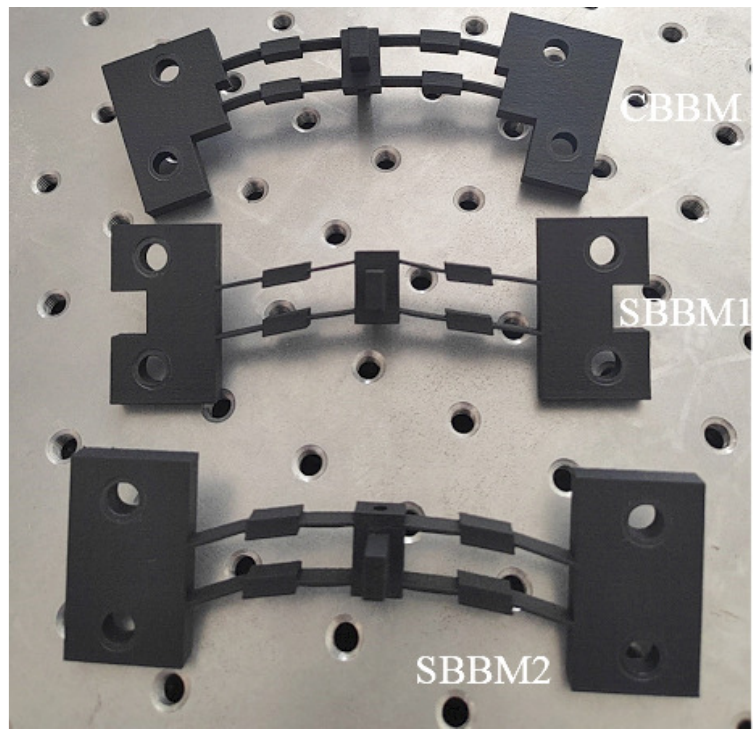
Figure 13. Photographs of prototype CBBM and SBBMs 1 and 2.